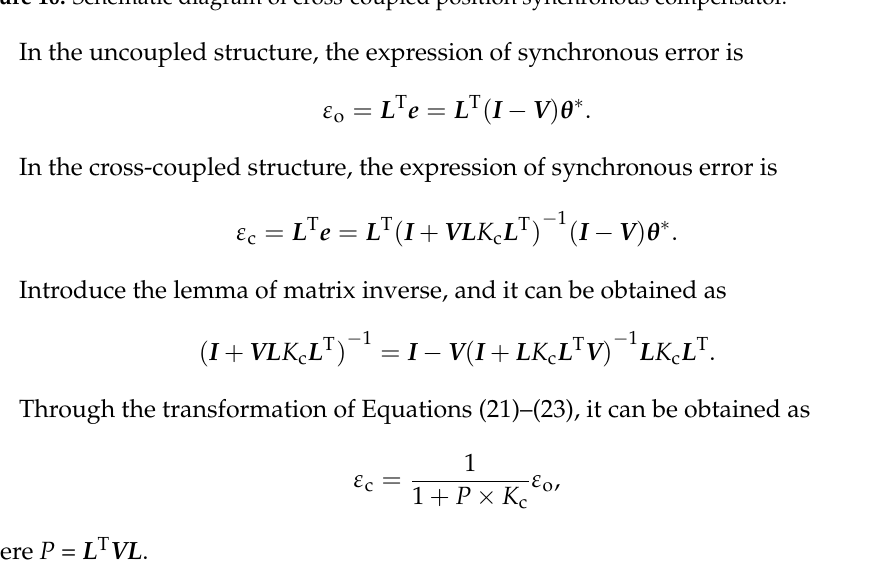
1 * θ 2 *] T ; θ = [ θ 1 θ 2 ] T ; e = [ e 1 e 2 ] T ; V = diag ( V 1 , V 2 ); L = [